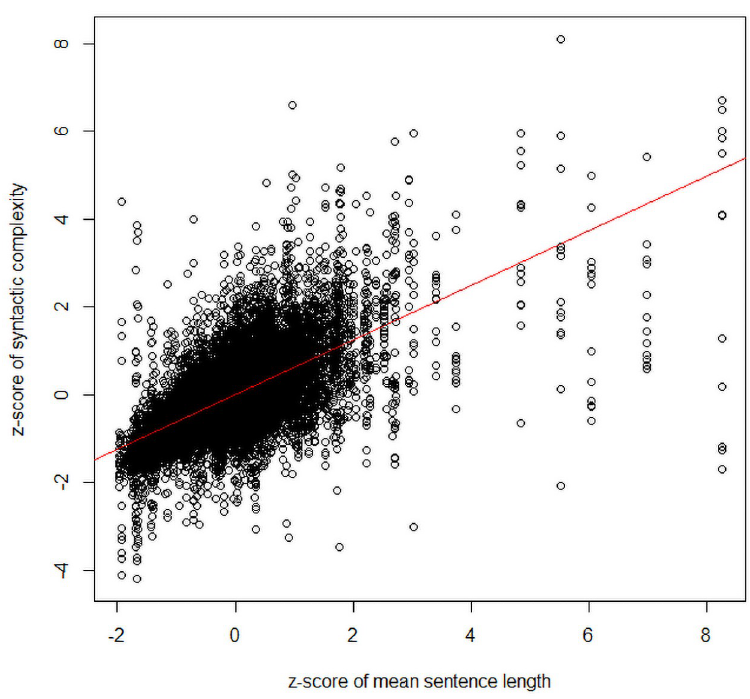
Fig 1. Syntactic complexity (z-score) as a function of number of mean sentence length (z-score) in text.